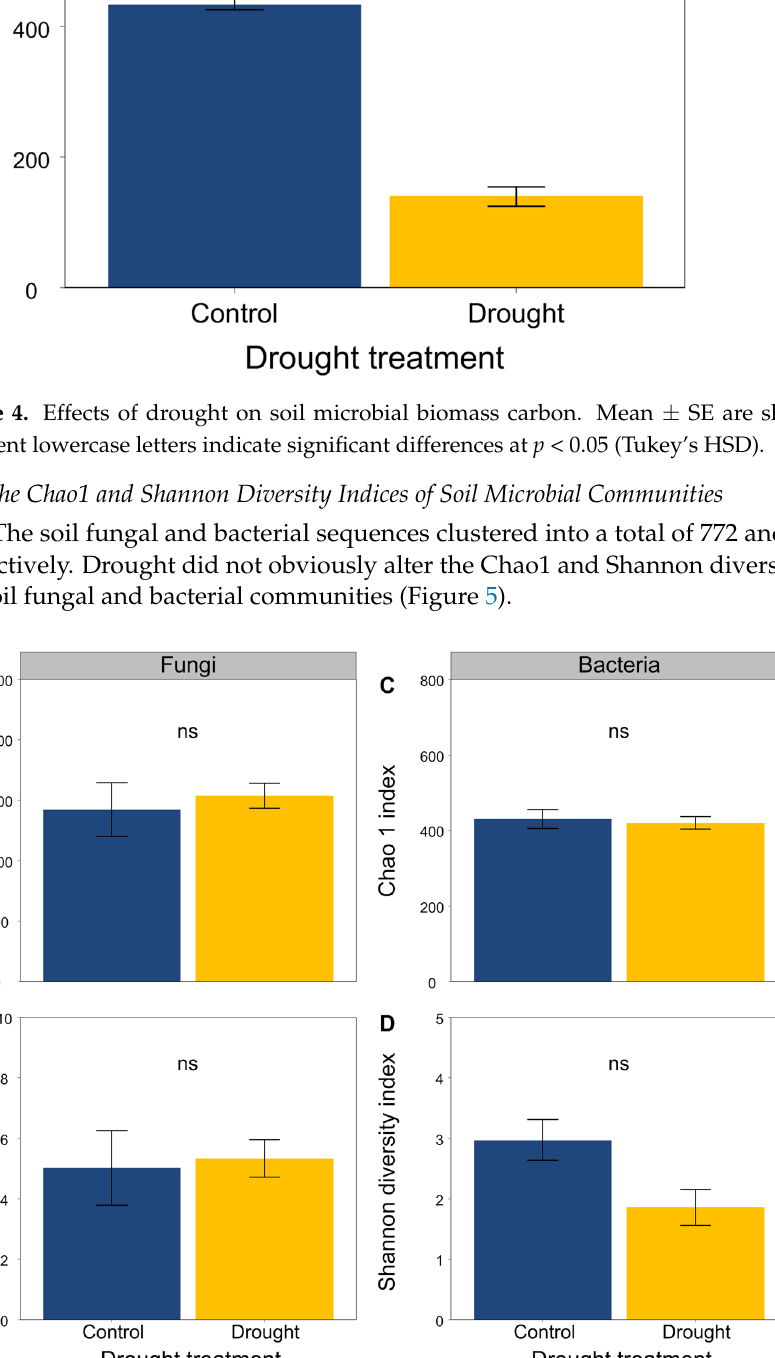
Figure 5. Effects of drought on ( A , B ) fungal and ( C , D ) bacterial community diversity. Mean ± SE are shown (n = 3). ns indicates no significant differences.